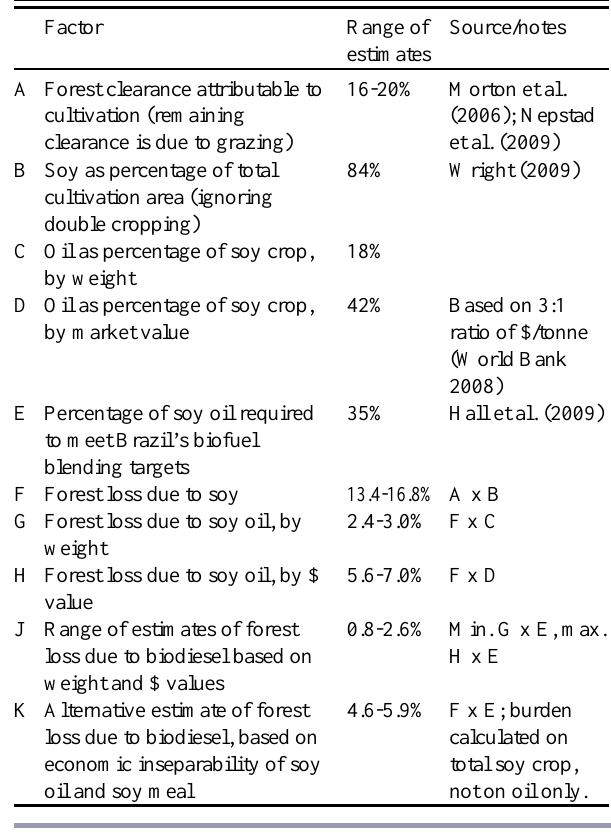
Table 1 . The burden of deforestation due to biodiesel in Mato